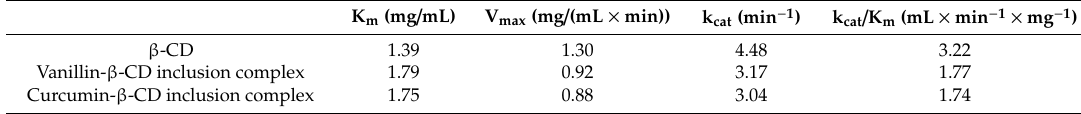
Table 1. The kinetic parameters of dual-enzyme action on β -CD and the CD complexes.